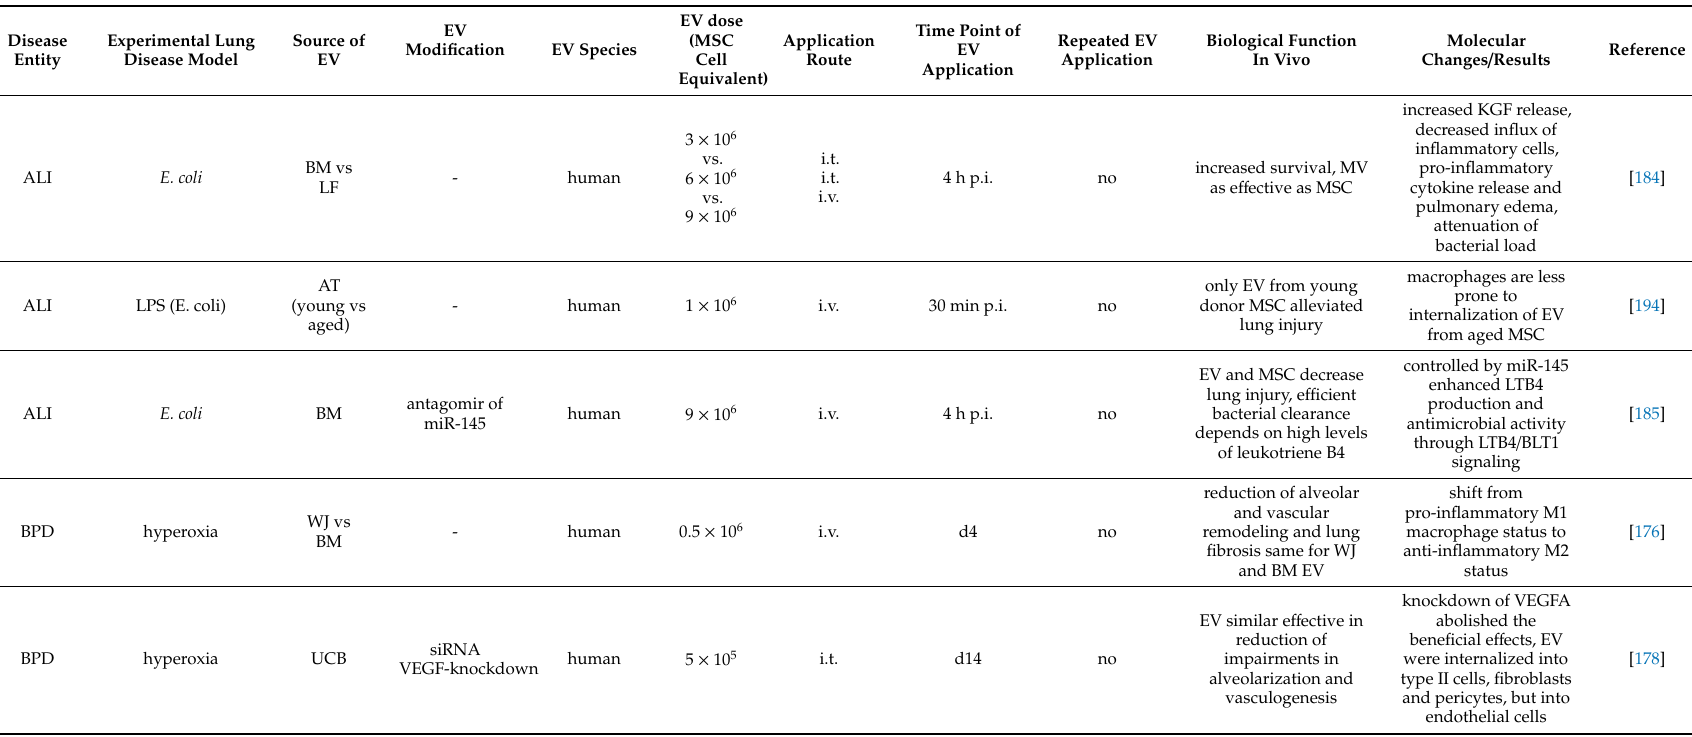
Table 9. Decisive preclinical studies in rodents to evaluate EV from MSC as alternative treatment option to conventional MSC